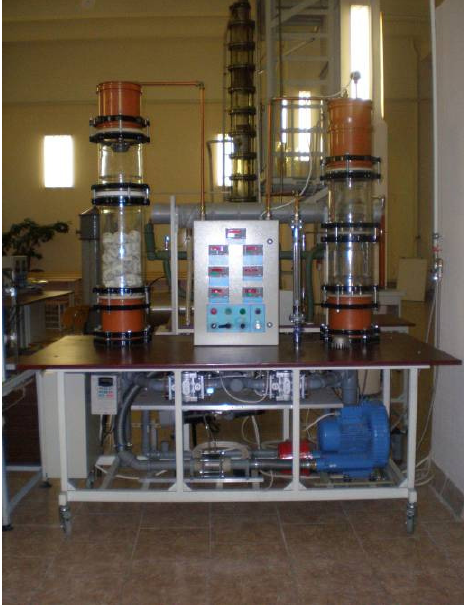
Fig. 5. Scheme of experimental equipment: 1 – column;